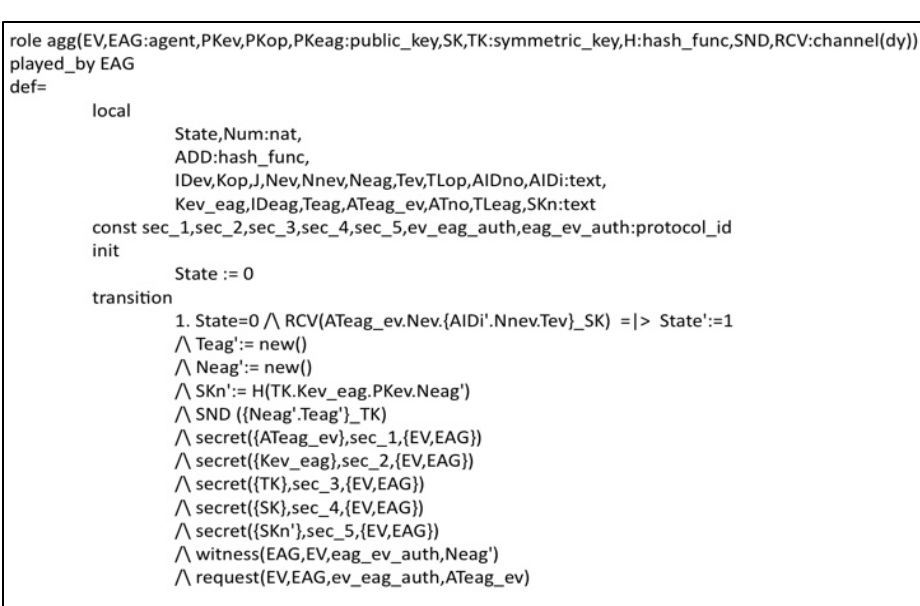
Figure 13. Reauthentication Specification of EV.